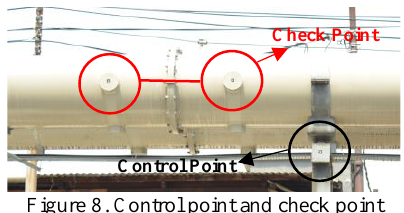
Figure 8. Control point and check point